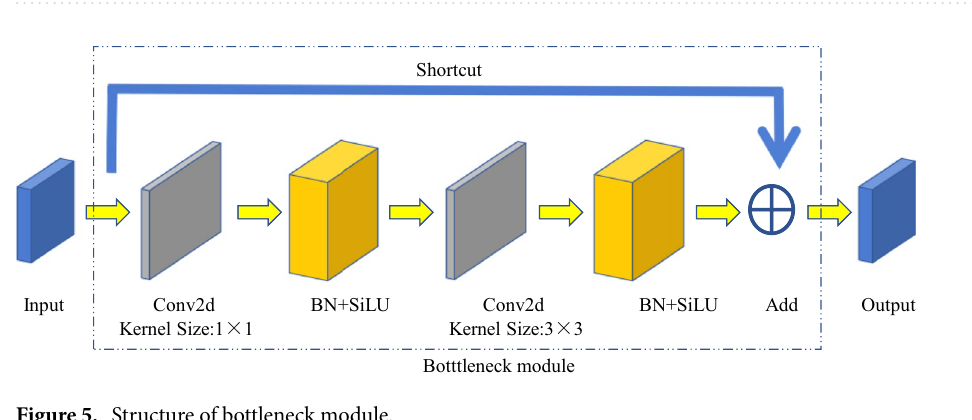
Figure 5. Structure of bottleneck